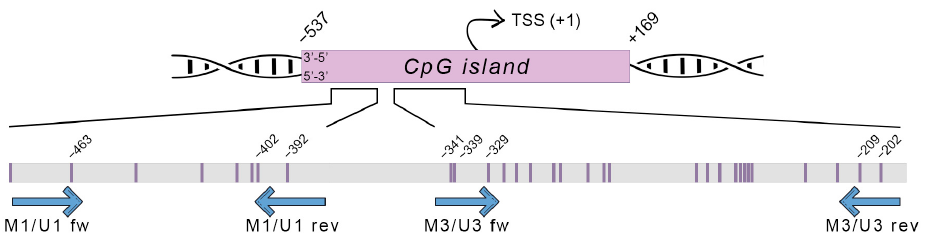
Figure 3. Scheme of the investigated CpG island encompassing the promoter region of the SRXN1 gene. Primer binding sites are shown in the inset with CpG dinucleotides marked as vertical lines. The position of the transcription starting site (TSS) is marked as “+1”; M1/U1 fw, M3/U3 fw: methylated and unmethylated forward primers, respectively; M1/U1 rev, M3/U3 rev: methylated and unmethylated reverse primers, respectively.